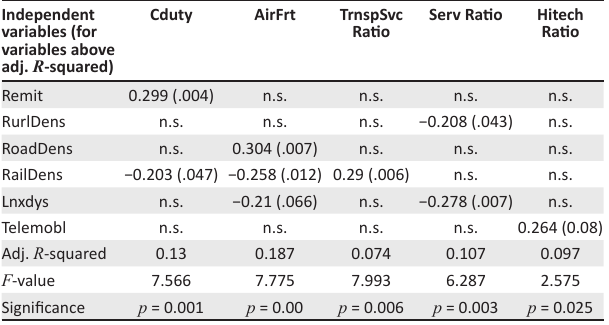
TABLE 5: Results for regressions for Equation 1 *